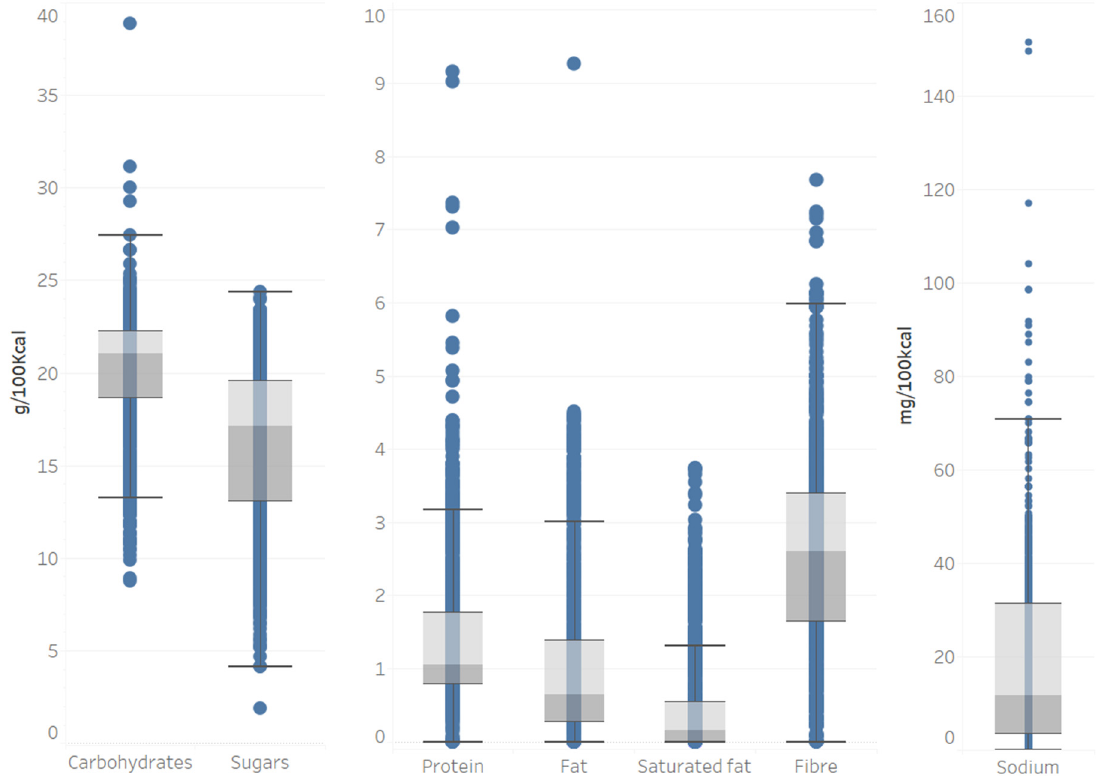
Figure A5. Nutrient content (g/100 kcal product, except for sodium mg/100 kcal product) of ‘Baby fruit products, desserts and yoghurts’.